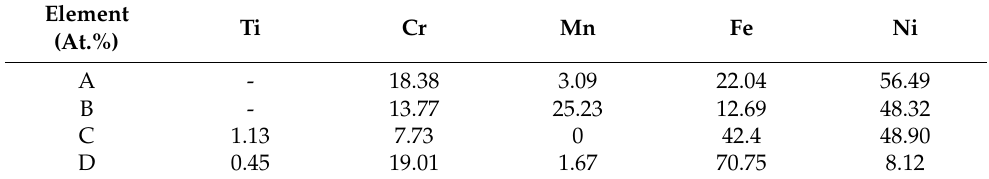
brazing alloy on substrates of sandblasting + 4 μm Ni at 1170 °C/25 min. A thin layer is